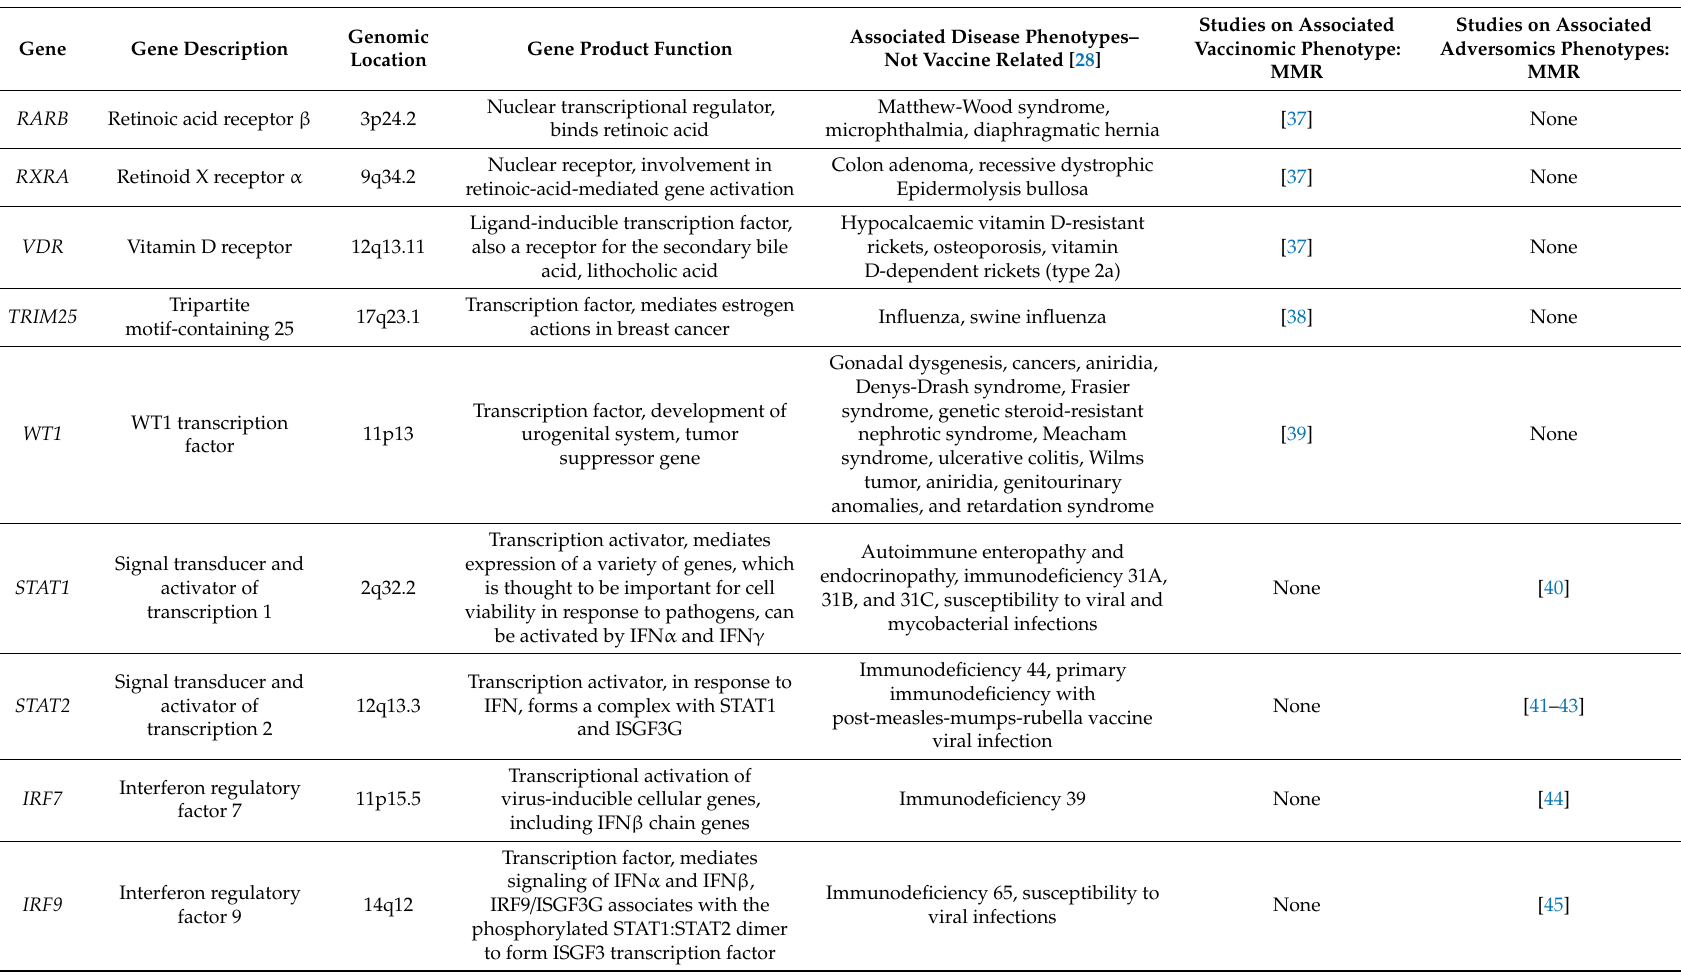
Table 3. Details of genes encoding transcription factors and transcription regulators associated with MMR vaccine e ffi cacy and